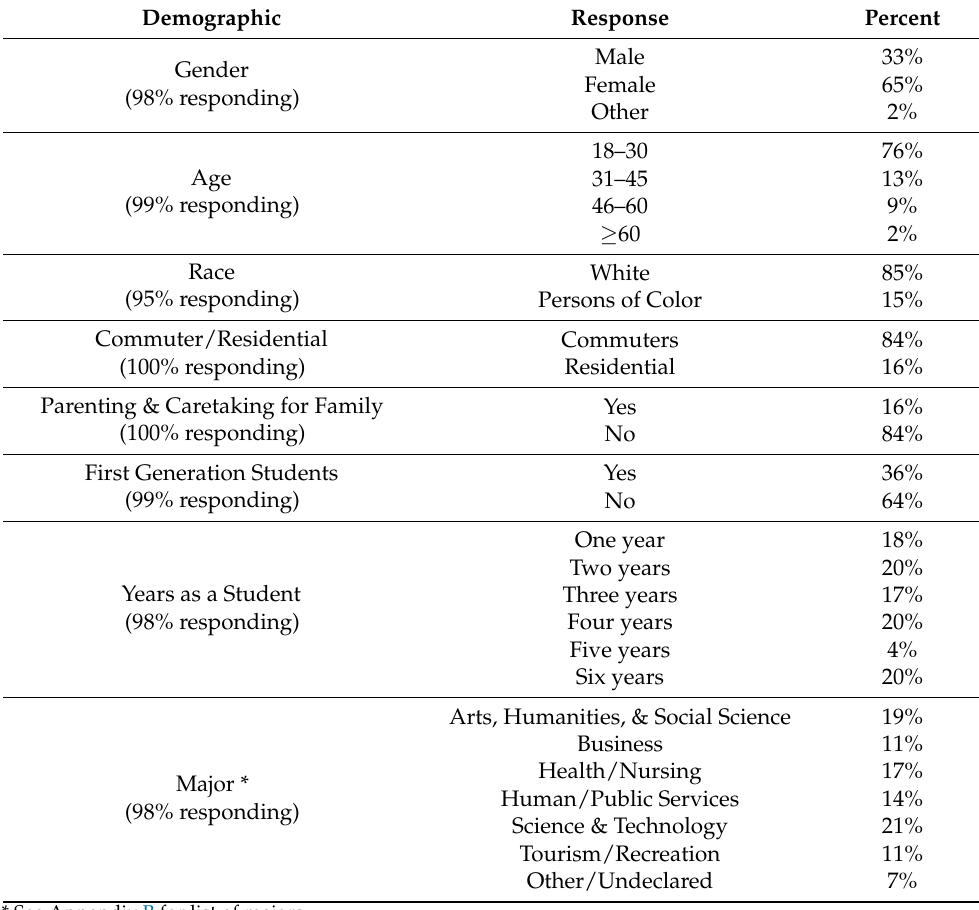
Table 1. Participant demographics denoted in